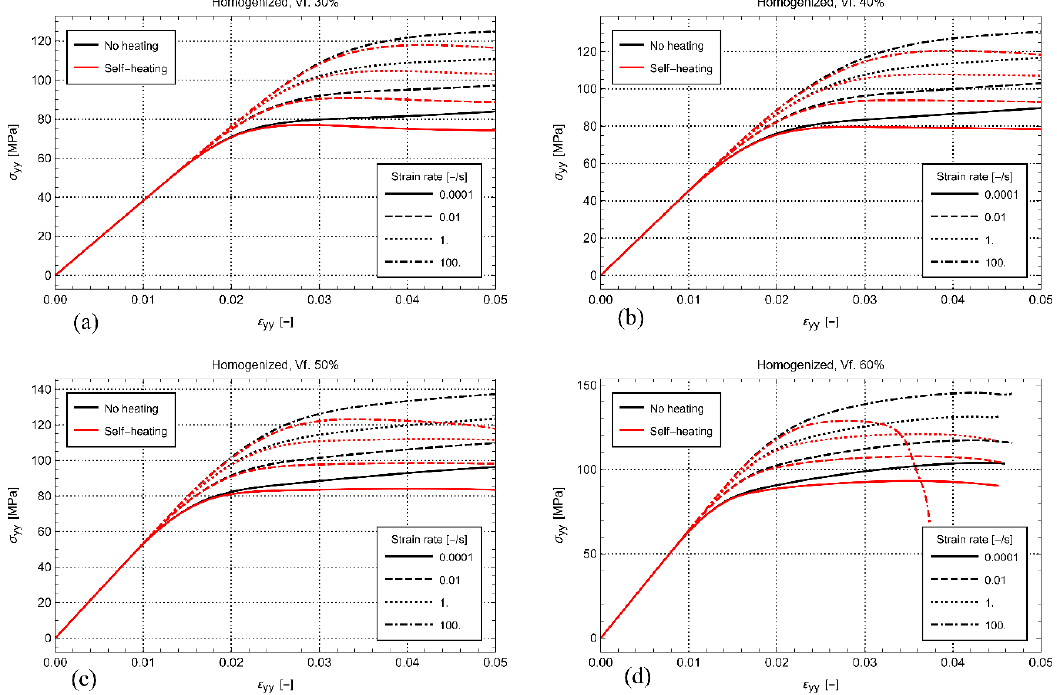
Figure 7. Homogenized stress-strain for the fiber volume fraction of 30% ( a ), 40% ( b ), 50% ( c ), and 60% ( d ) at several strain rates.